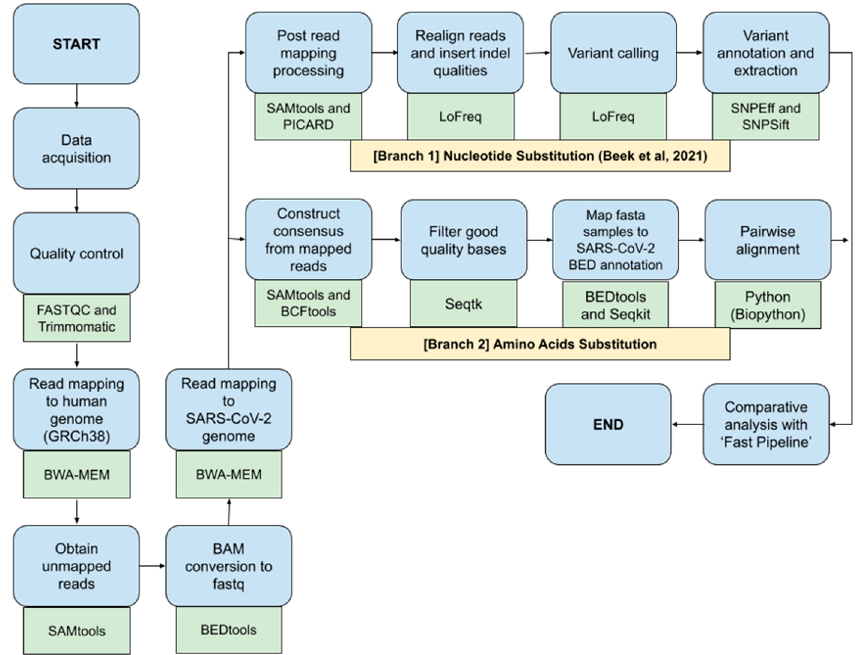
Figure 2. Normal Pipeline scheme; blue shapes represent the method; green shapes represent the tools used in each